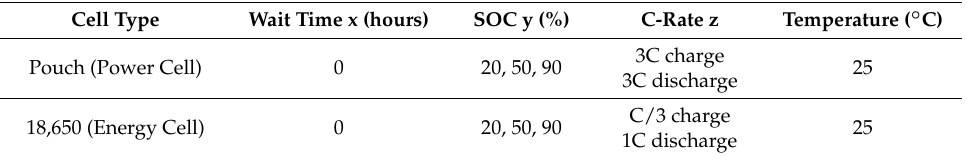
Table 2. Test parameters for the accelerated